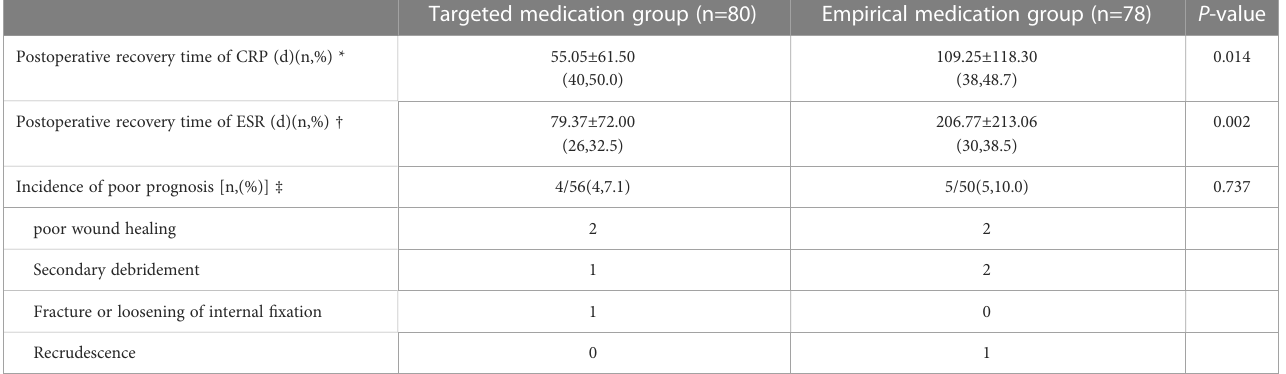
TABLE 3 The comparison of the time for CRP and ESR to return to normal and the incidence of poor prognosis between the two groups.